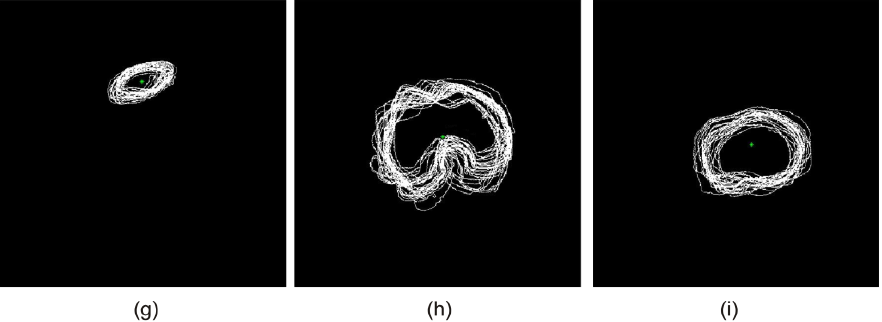
Figure 4. Superposition of selected 3rd ( a – c ), 6th ( d – f ), and 9th ( g – i ) set of the teaching group on the transverse plane along with the centroid marked for the patella, femur, and tibia, respectively. Quite a similar situation is presented for the sagittal plane (Figure 5). This figure presents the operation of superposition for the selected 3rd, 6th, and 9th set of the teaching group on the sagittal plane together with the designated centroid for the patella, femur, and tibia, respectively.